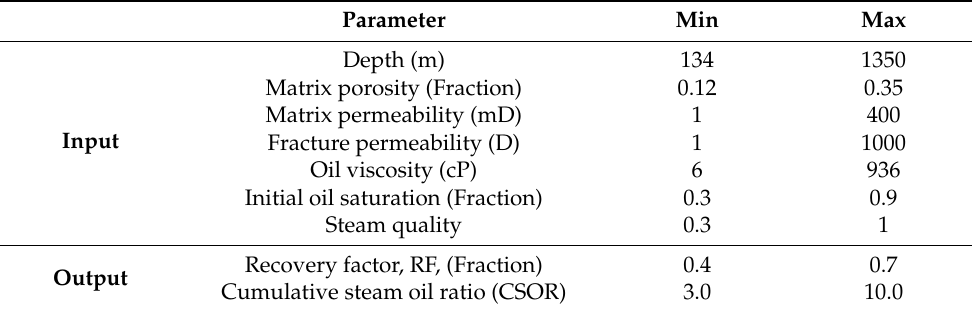
Table 10. Range of variables to estimate RF and